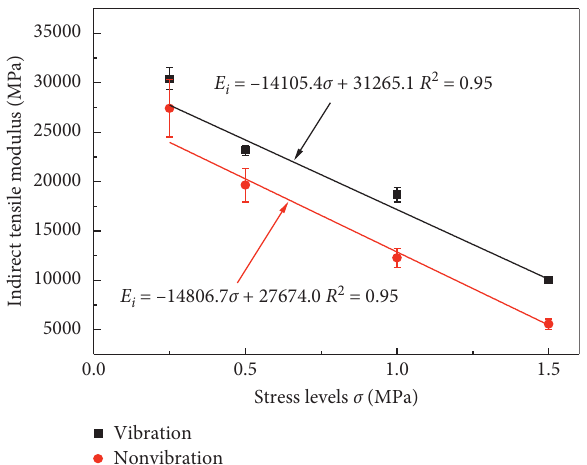
Figure 9: Indirect tensile modulus of cement-treated aggregates affected by stress levels.